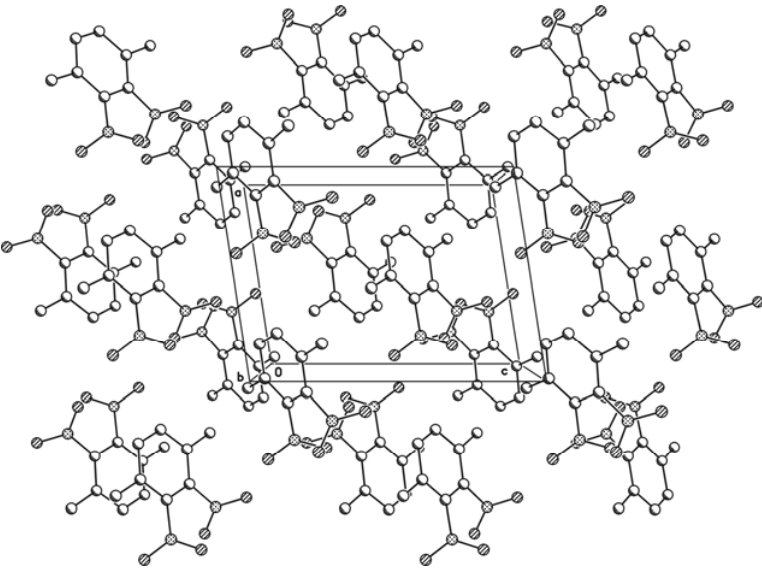
Figure 2. Crystal packing of